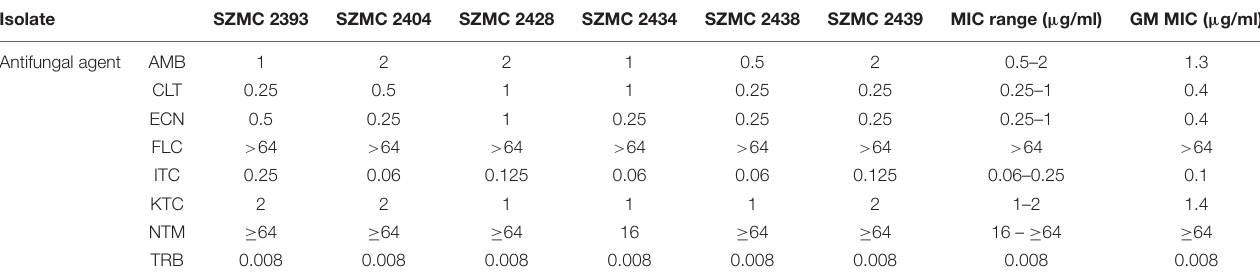
TABLE 3 | Minimum inhibitory concentration (MIC; µ g/ml) values of antifungal agents for six Aspergillus tamarii isolates from human keratomycosis. Isolate